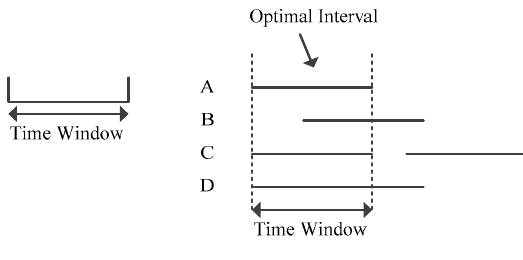
Figure 1. Problem Definition.